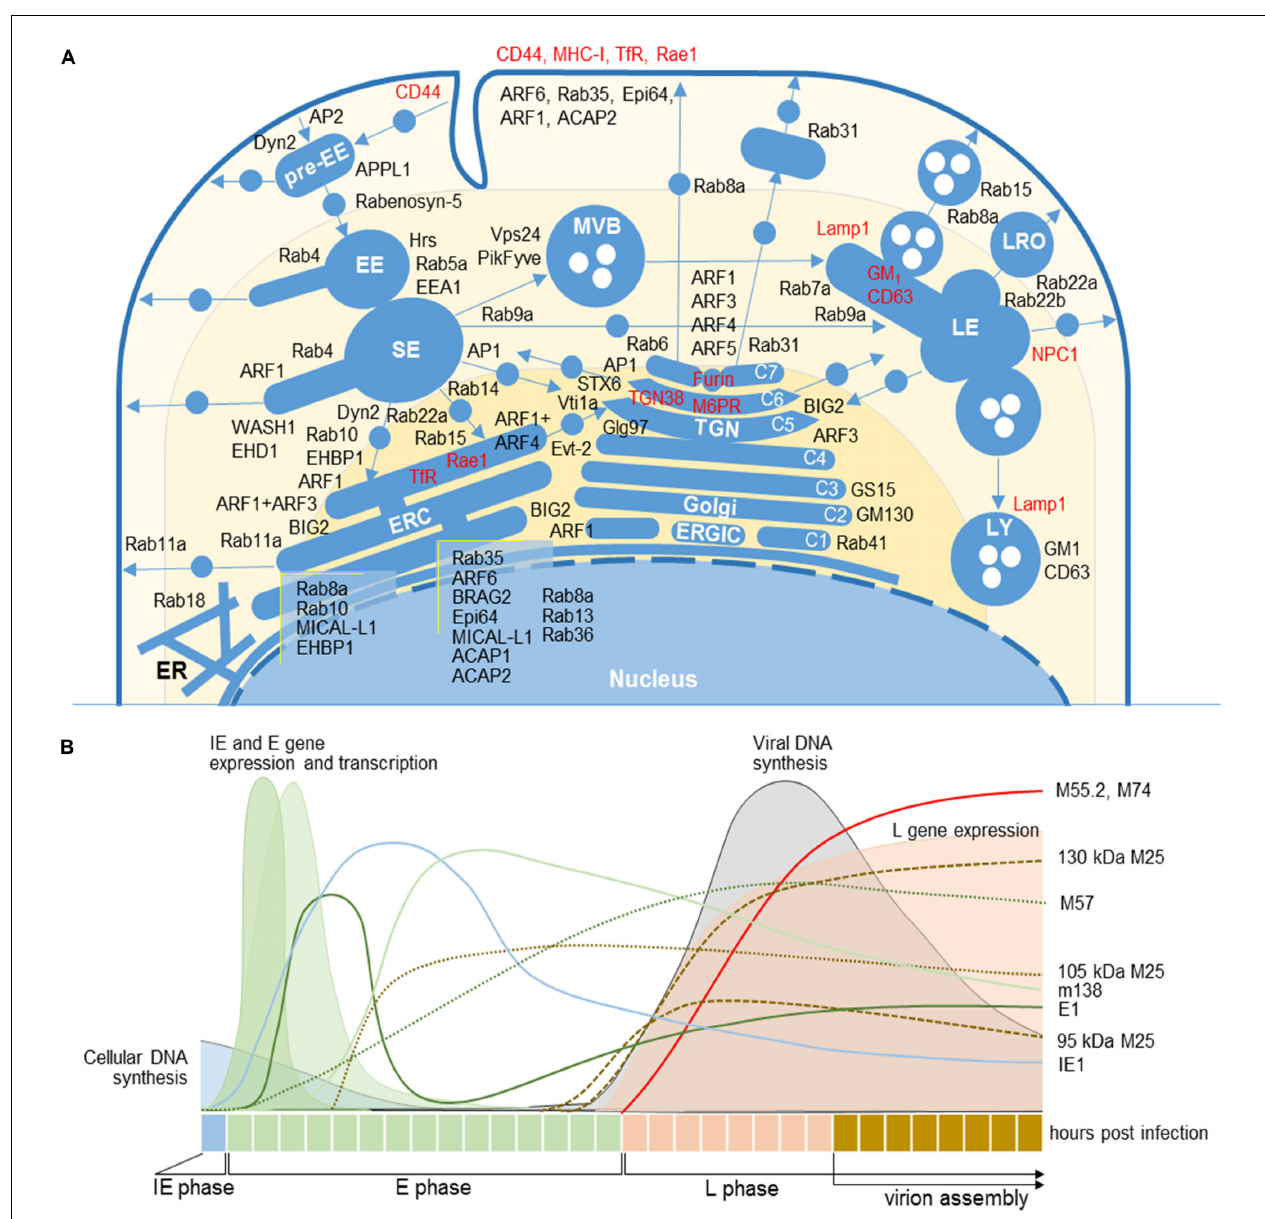
FIGURE 1 | Cellular and MCMV markers used in this study. (A) Subcellular distribution of host-cell markers in membranous organelles indicates major sites of their retention or activation/recruitment to membranes (For references see Supplementary Table S2 ). Markers that circulate within the membranous system are labeled in red. EE, early endosome; ER, endoplasmic reticulum; ERC, endosomal recycling compartment; ERGIC, endoplasmic reticulum-Golgi intermediate compartment; LE, late endosome; LRO, lysosome-related organelles; LY, lysosome; MVB, multivesicular body; SE, sorting endosome; TGN, trans-Golgi network. C1-C7, cisternae of the Golgi stack. (B) Organization of the MCMV life cycle and expression kinetics of MCMV genes that encode proteins of interest for this study. The schematic presentation is based on the published data (Scrivano et al., 2010; Marcinowski et al., 2012; Kutle et al., 2017). IE, immediate early phase; E, early phase; L, late phase; 11/2-column fitting